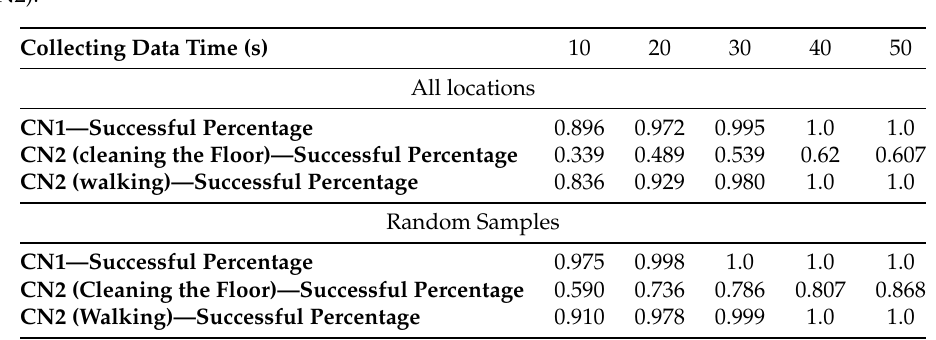
Table 6. Success percentages (the triangulation error is below 15 cm) within 1000 experiments of the proposed method which is conducted with the Camera Network 1 (CN1), and Camera Network 2